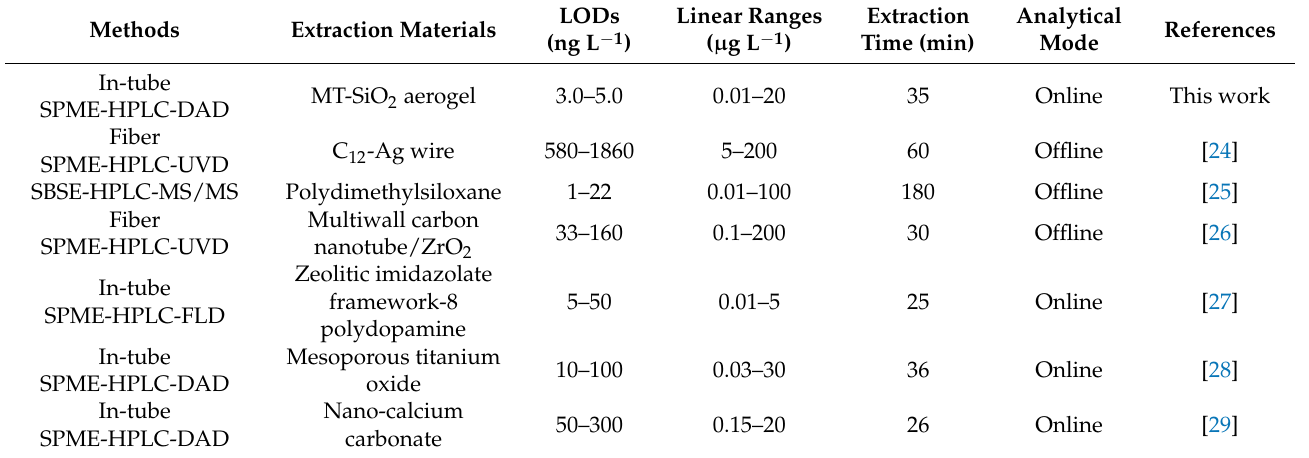
Table 3. Comparison of the analytical method with other methods for the determination of